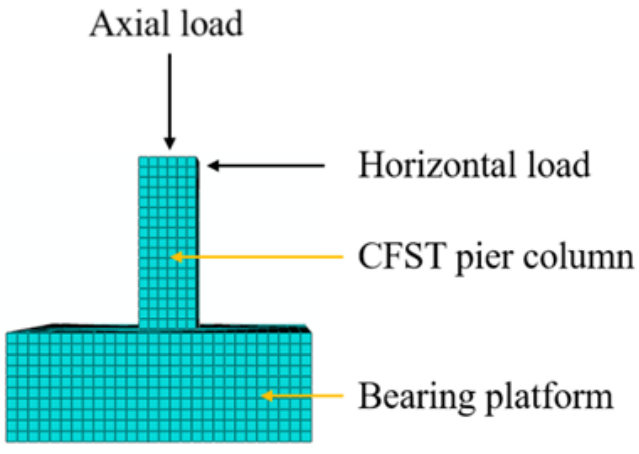
Figure 8. Schematic views of FE model under cyclic load.